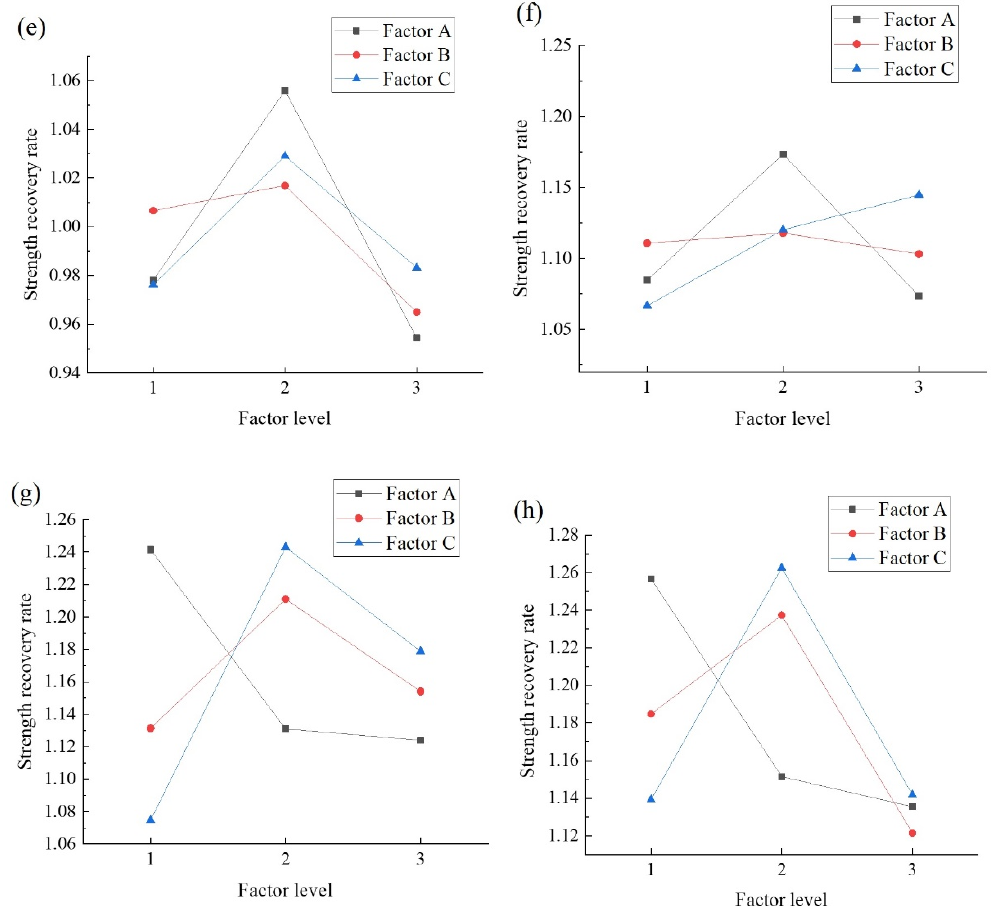
Figure 3. K -value of the compressive strength recovery rate for various factors. ( a ) 100% damage of specimens at 7 d. ( b ) 90% damage of specimens at 7 d. ( c ) 80% damage of specimens at 7 d. ( d ) 70% damage of specimens at 7 d. ( e ) 100% damage of specimens at 28 d. ( f ) 90% damage of specimens at 28 d. ( g ) 80% damage of specimens at 28 d. ( h ) 70% damage of specimens at 28 d.